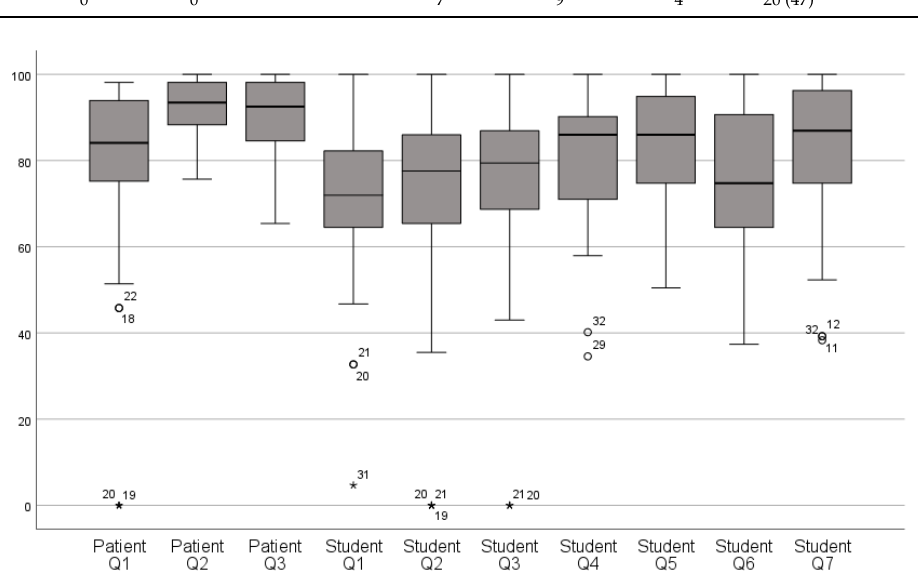
Figure 4. Boxplot with median and interquartile range of patient and operator VAS scores. (° = outliers; * = most extreme outlier; numbers = case numbers.)